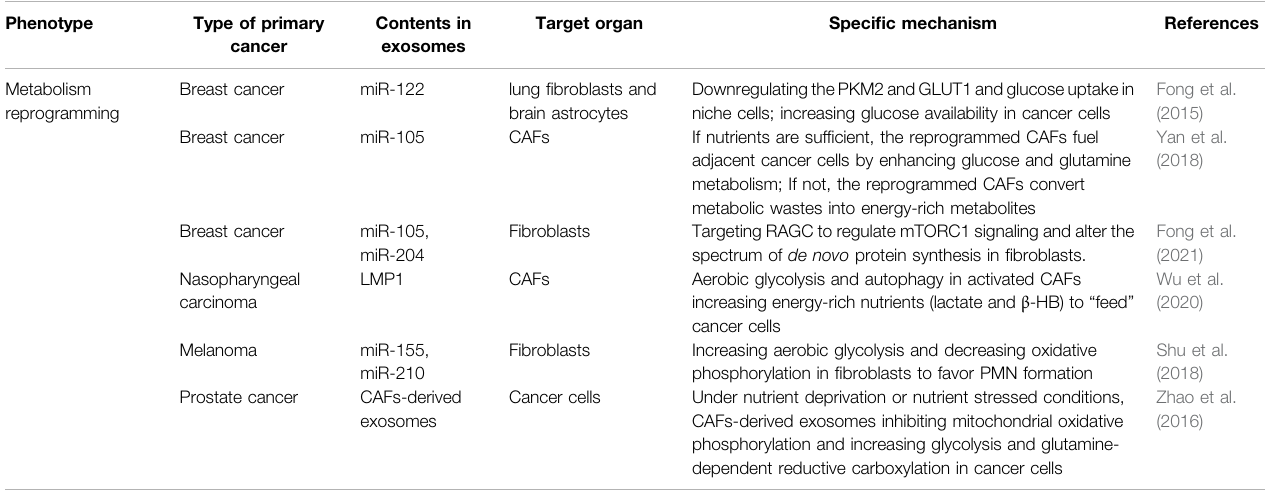
TABLE 4 | The role of exosomes in metabolism